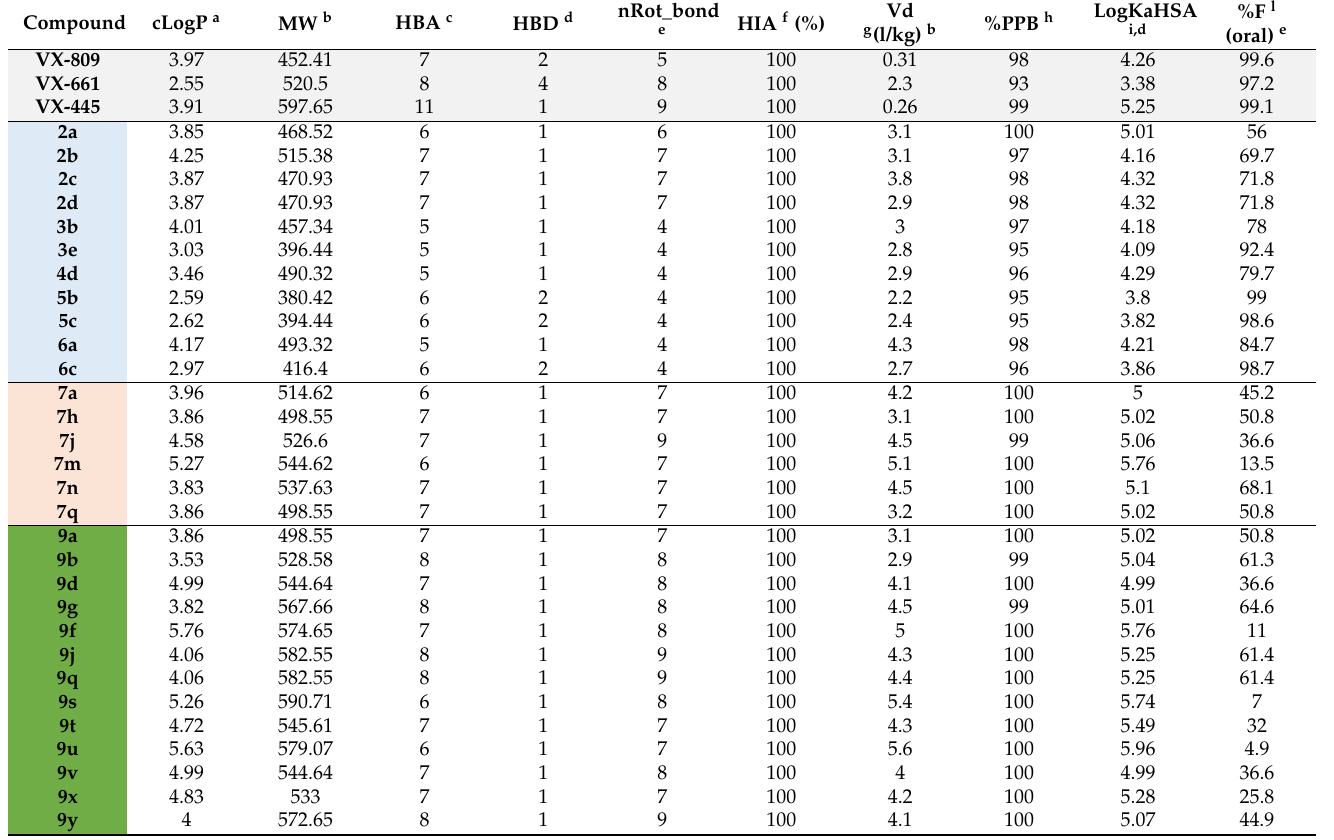
Table 4. Calculated ADME properties as representative of the absorption and distribution features for a number of hybrid derivatives and for the drug-like correctors VX-809, VX-661, and VX-445, taken as reference compounds (highlighted in grey). Hybrids discovered within the first [27] and the second series [28] are depicted in cyan and light orange, respectively. Newly discovered analogues, reported within the third series of hybrids, are reported in